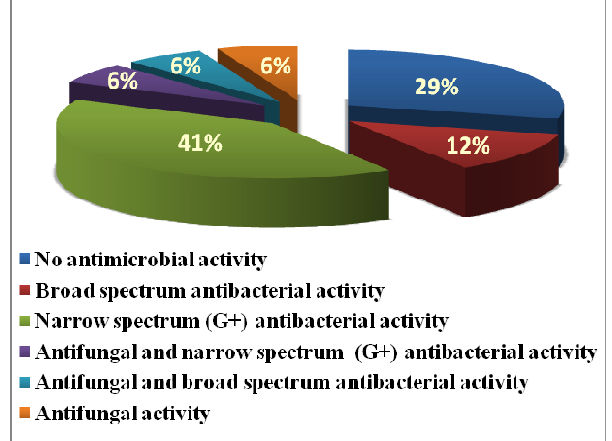
Figure 4. The antimicrobial spectrum of tested